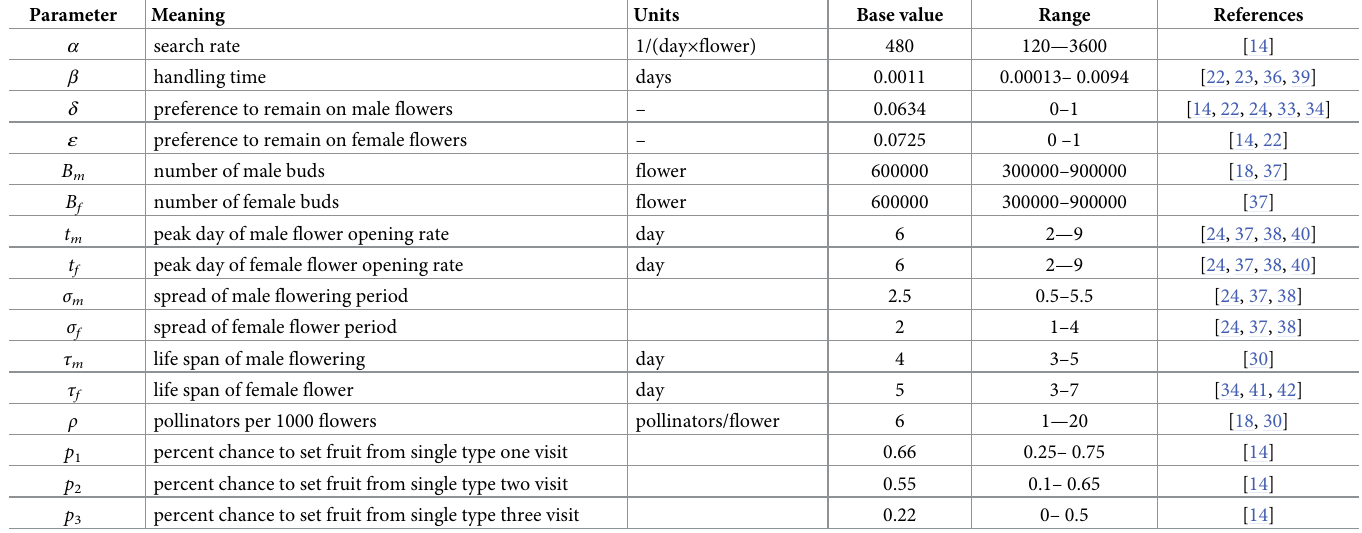
Table 2. Model parameters, base values and ranges used in